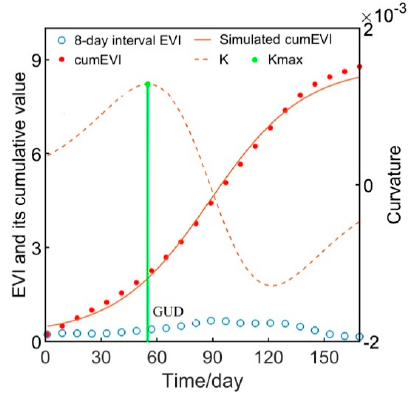
Figure 2. Illustration of winter wheat GUD extraction. K represents the curvature of the fitted cumEVI. Kmax indicates the maximum of